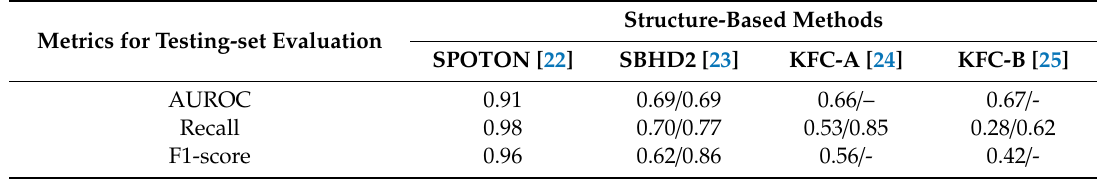
Table 3. Structure-based HS prediction performances. Metrics for Testing-set